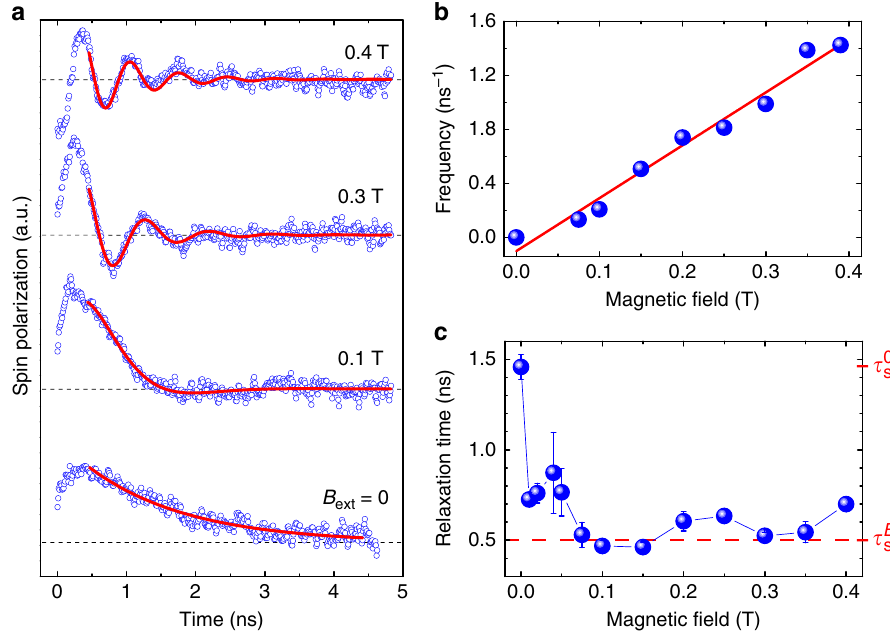
Figure 4 | Magnetic-field effects on the spin dynamics. ( a ) Typical time-resolved transients of the spin polarization for a single, free-standing WZ GaAs NW at 4.2K for transverse applied magnetic fields from 0 to 400mT. The transients are fitted to a single exponential for B ext ¼ 0 and to a damped cosine (continuous red lines) for B ext 4 0, respectively, accounting for Larmor precession in non-zero magnetic fields. ( b ) Extracted values of the Larmor precession frequency as a function of the externally applied transverse magnetic field. From a linear fit to the data (continuous red line) we determine the absolute value of the effective electron g -factor in WZ GaAs NWs to be | g *| ¼ 0.28 ± 0.02. ( c ) Variation of the spin relaxation time t s as a function of the transverse applied magnetic field. The sudden decrease of t s in an external magnetic field reflects an intrinsic spin relaxation anisotropy, with spins pointing along the NW axis relaxing substantially slower than spins perpendicular to the NWaxis. The dashed red line marks the drop from the zero-field value t s 0 to t s B E t s 0 /3 in a transverse field. Error bars correspond to the s.e. for fitting the spin polarization | g *| ¼ 0.28 ± 0.02. This value is remarkably different from its zincblende counterpart (that is, | g *| ¼ 0.44) 38 .